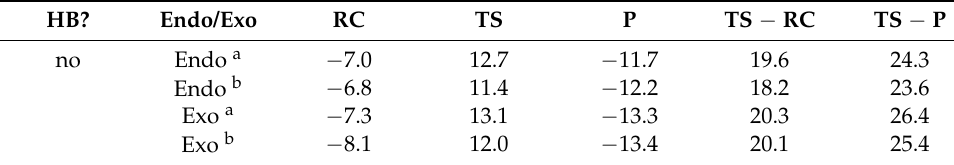
Table 5. The energetics of the Diels–Alder reactions between Maleimide and ester-functionalized furan (with ester group instead of hydroxyl functionality) using enthalpies H at 298.15 K. Values are relative to the separate reagents and given in kcal mol − 1 . RC: reactant complex; TS: transition state; P: